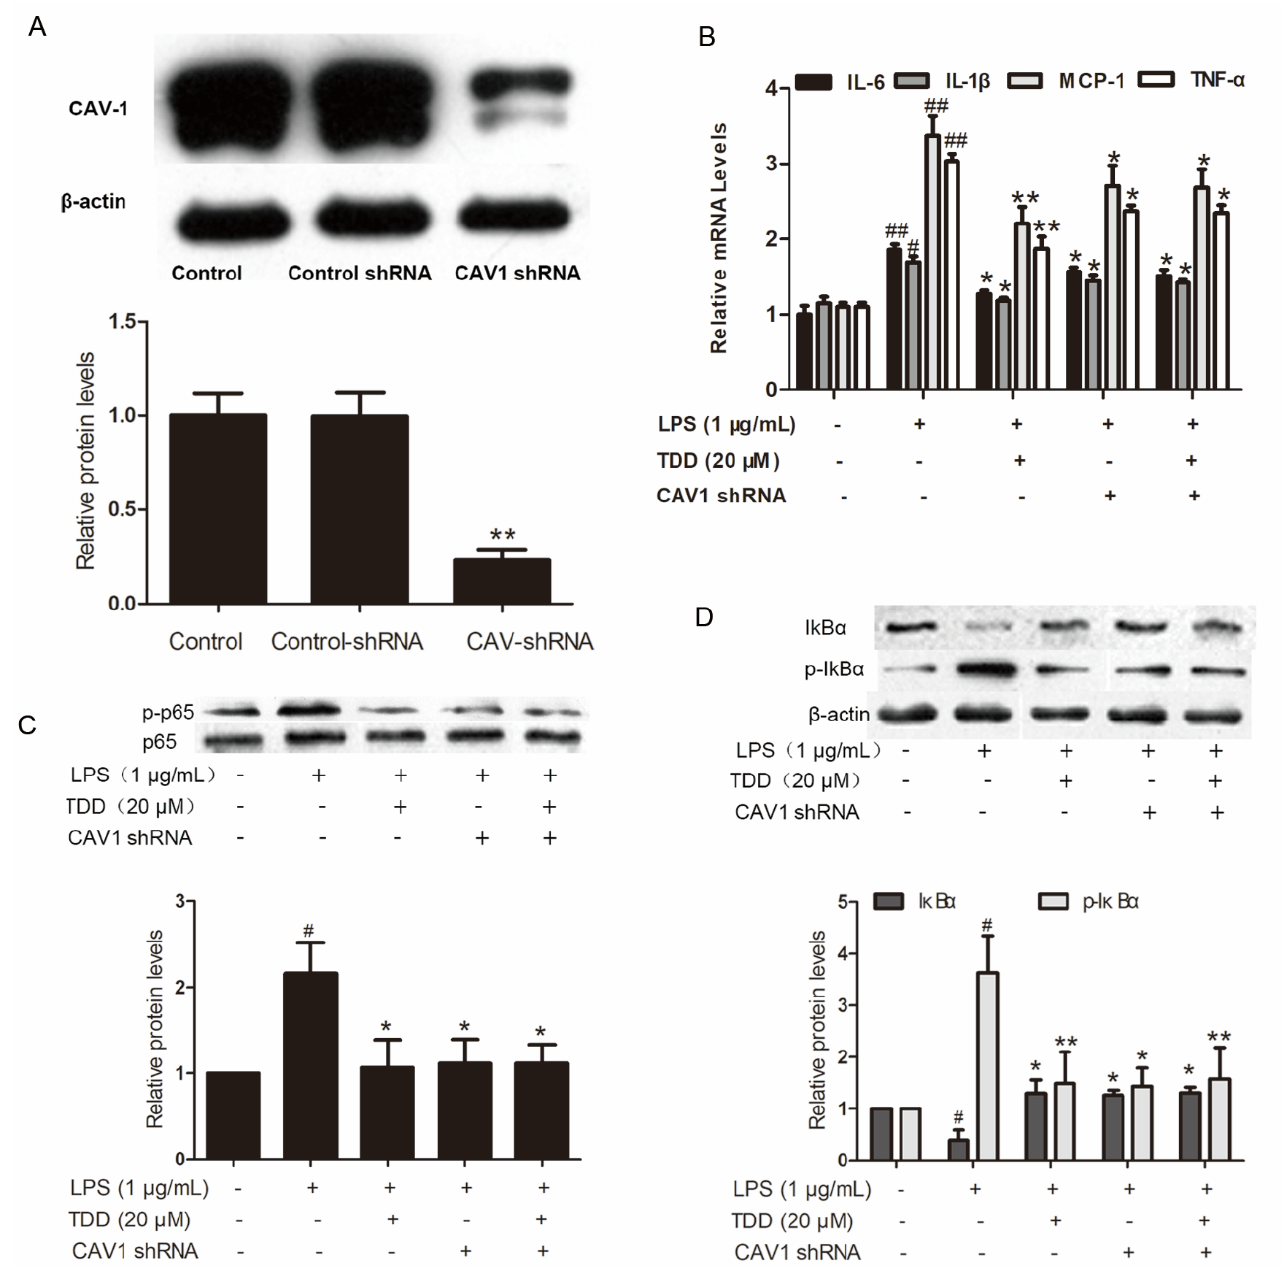
Figure 6. Effects of TDD on the Cav1-NF- κ B axis in LPS-treated EA.hy926 cells. ( A ) Effects of shRNA on the expression of Cav1 in EA.hy926 Cells. The data show the mean ± S.D. of three independent experiments. * p < 0.05 and ** p < 0.01, compared to the control group; ( B ) effects of TDD on LPS-stimulated the IL-6, IL-1 β , MCP-1, and TNF-a mRNA expression was determined by real-time RT-PCR with or without transfecting Cav1 shRNA, and; ( C , D ) effects of TDD on p65 and I κ B α activation and I κ B α degradation in LPS-stimulated EA.hy926 cells with or without transfecting Cav1 shRNA. The data show the mean ± S.D. of three independent experiments. * p < 0.05, and ** p < 0.01, compared to the LPS (+) TDD ( − ) CAV1 shRNA ( − ) group. # p < 0.05, ## p < 0.01 compared to the LPS ( − ) TDD ( − ) group.